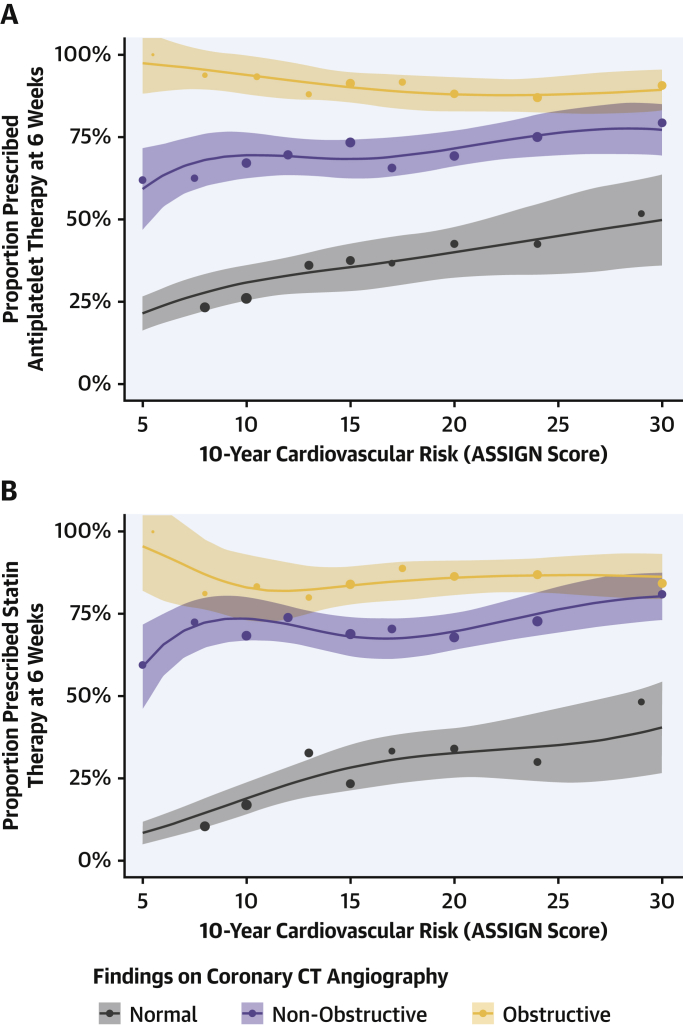
Interaction Between Coronary CT Angiography Findings and Clinically Estimated Cardiovascular Risk in Relation to Prescribing of Preventative TherapyFrequency of prescribing for (A) antiplatelet and (B) statin therapy at 6 weeks in patients with obstructive (orange) and nonobstructive (purple) coronary artery disease, and normal coronary arteries (gray) on coronary computed tomography (CT) angiography across a range of 10-year cardiovascular risk as determined from the ASSIGN score (11). The lines and corresponding shaded areas represent the prescribing estimates and 95% confidence intervals derived from a regression model. The dots represent the observed prescribing rates among the trial cohort grouped according to ASSIGN score with size proportional to the number of patients included in each group.